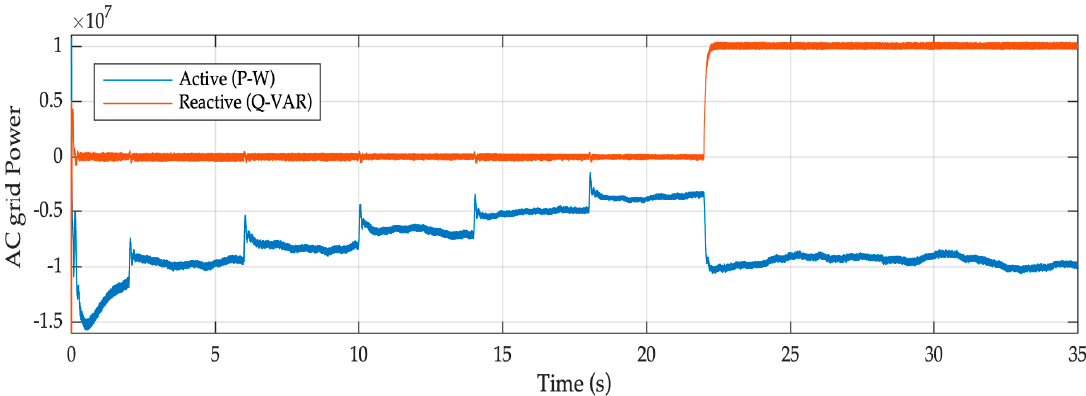
Figure 9. Active and reactive power generated by the DREA at the distribution grid.